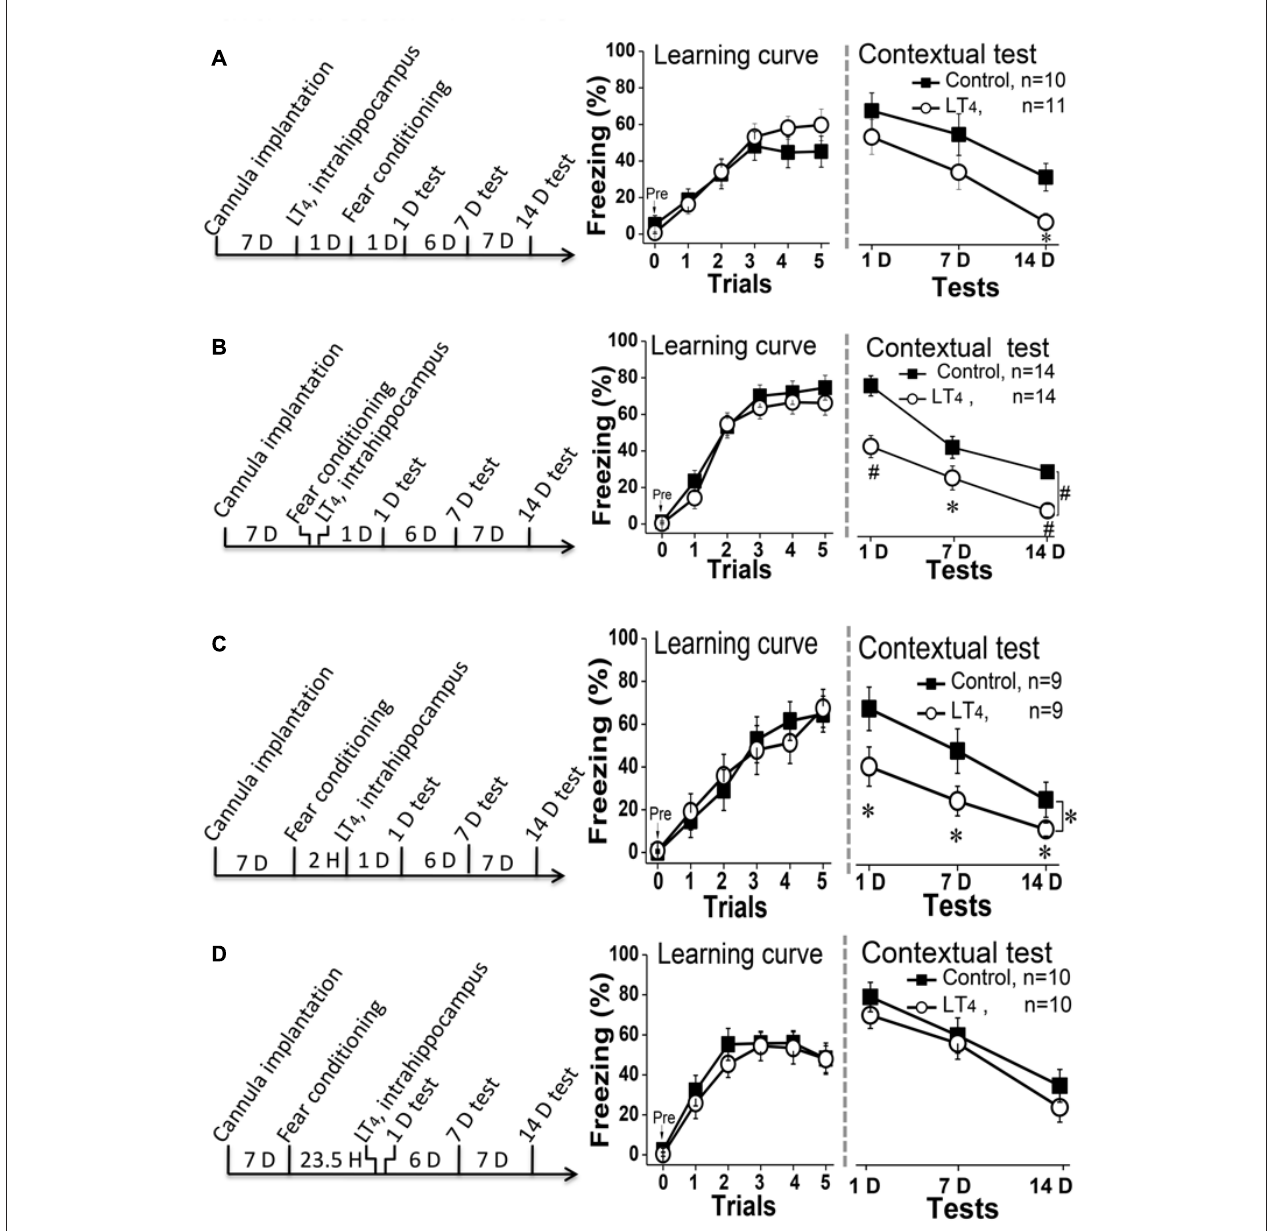
FIGURE 3 | Effects of hippocampal injection of LT 4 on contextual fear memory. (A) Left: hippocampal injection of LT 4 1 day before fear conditioning training; Middle: the learning curve during fear conditioning training; Right: contextual fear memory tests 1 day, 7 days and 14 days after training. (B) Left: hippocampal injection of LT 4 immediately after fear conditioning; Middle: the learning curve during fear conditioning training; Right: contextual fear memory tests. (C) Left: hippocampal injection of LT 4 2 h after fear conditioning; Middle: the learning curve during fear conditioning training; Right: contextual fear memory tests. (D) Left: hippocampal injection of LT 4 30 min before contextual fear memory test; Middle: the learning curve during fear conditioning training; Right: contextual fear memory tests. LT 4 , levothyroxine; H, hour; D, day. ∗ P < 0.05, # P <